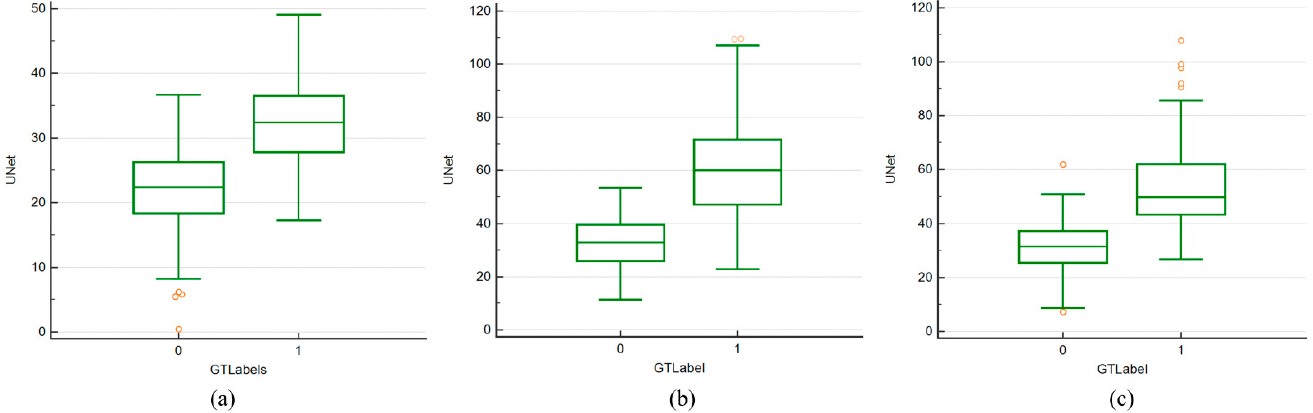
Figure 10. Comparison of ANOVA test curves for Unseen AI and Seen AI database experiments. ( a ) Experiment #1 (Unseen AI-1 (Tr: JAP, Te: HK)) ( b ) experiment #2 (Unseen AI-2 (Tr: HK, Te: JAP)) ( c ) experiment #3 (Seen AI-1 CV w/ Mixed).